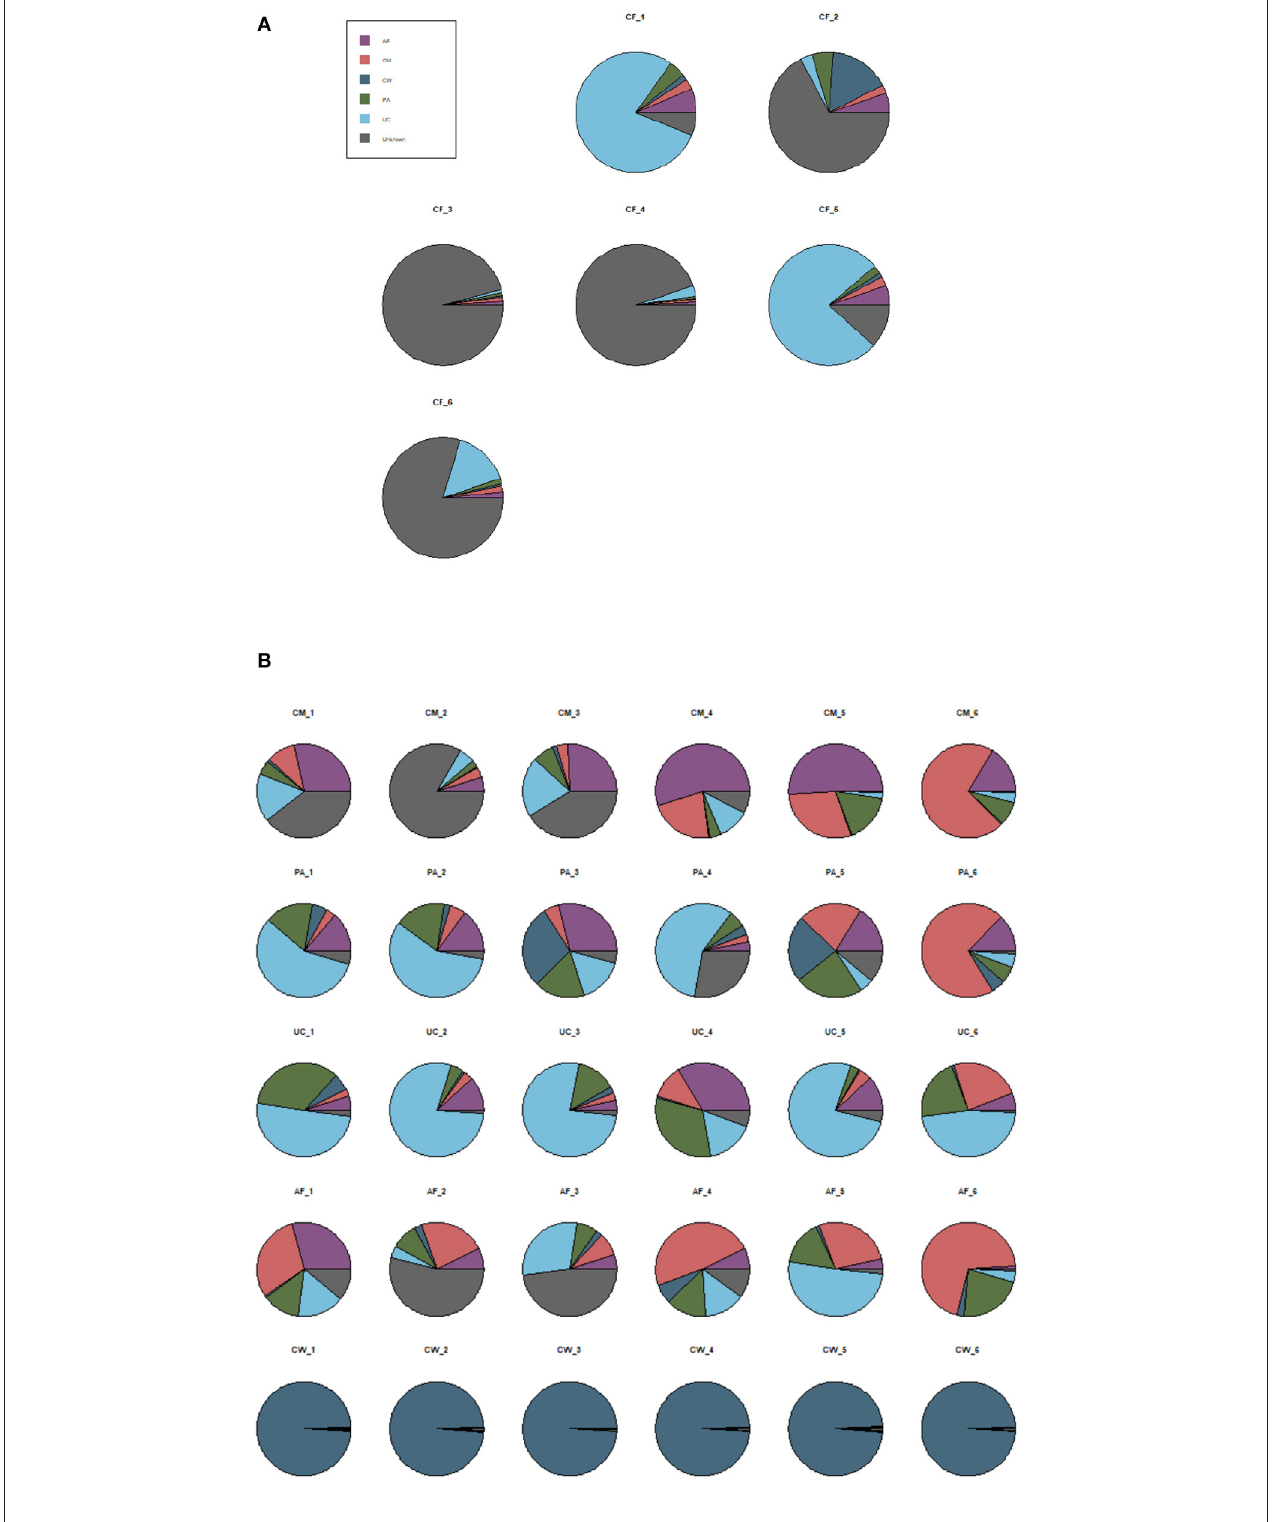
FIGURE 6 | SourceTracker proportion estimates for a subset of “sink” samples and different “source” samples. (A) The matching ratio of microorganisms between meconium and different maternal sample types. (B) The matching ratio among the five “source” environments. AF, amniotic fluid; CF, calf meconium; CM, colostrum; CW, cow feces; PA, placenta; UC, umbilical cord; Unknown, unknown parts.